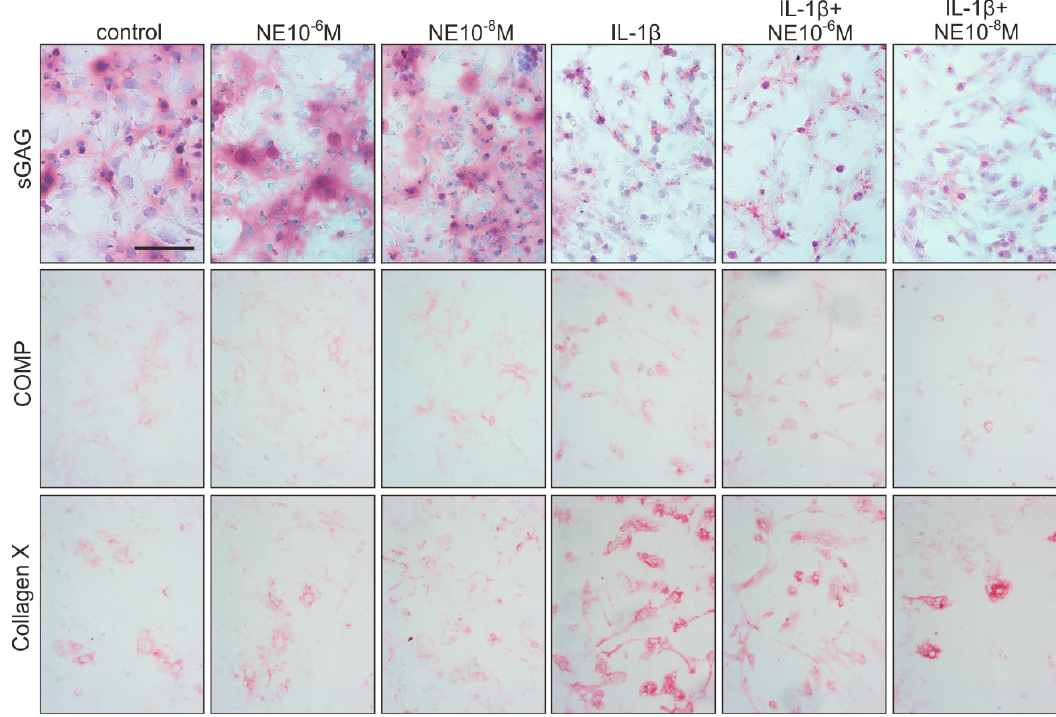
Figure 6. Effects of NE and IL-1 β on ECM deposition. DMMB staining of sGAGs and immunohistochemical detection of COMP and type X collagen in OA chondrocyte cultures after seven days under NE or/and IL-1 β influence and physioxic conditions (representative images of cells isolated form one OA patient). Scale bar represents 100 μ m. Int. J. Mol. Sci. 2019 , 20 , x FOR PEER REVIEW